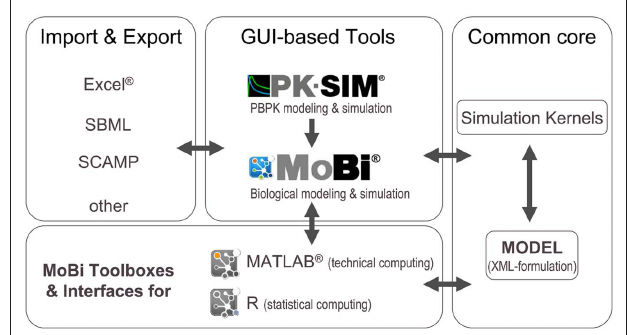
Figure 2 | Modular structure of the software platform. In the center of the platform are PK-Sim ® , MoBi ® , and the MoBi ® toolboxes for R and MATLAB ® . While all tools allow simulation and result visualization, PK-Sim ® and MoBi ® are designed for modeling and low through-put simulations, while the toolboxes allow batch simulations and additional analysis tasks. A common XML-file format can be interpreted by the different programs. Additional flexibility is provided through import and export functions. (Trademark information: see Materials and